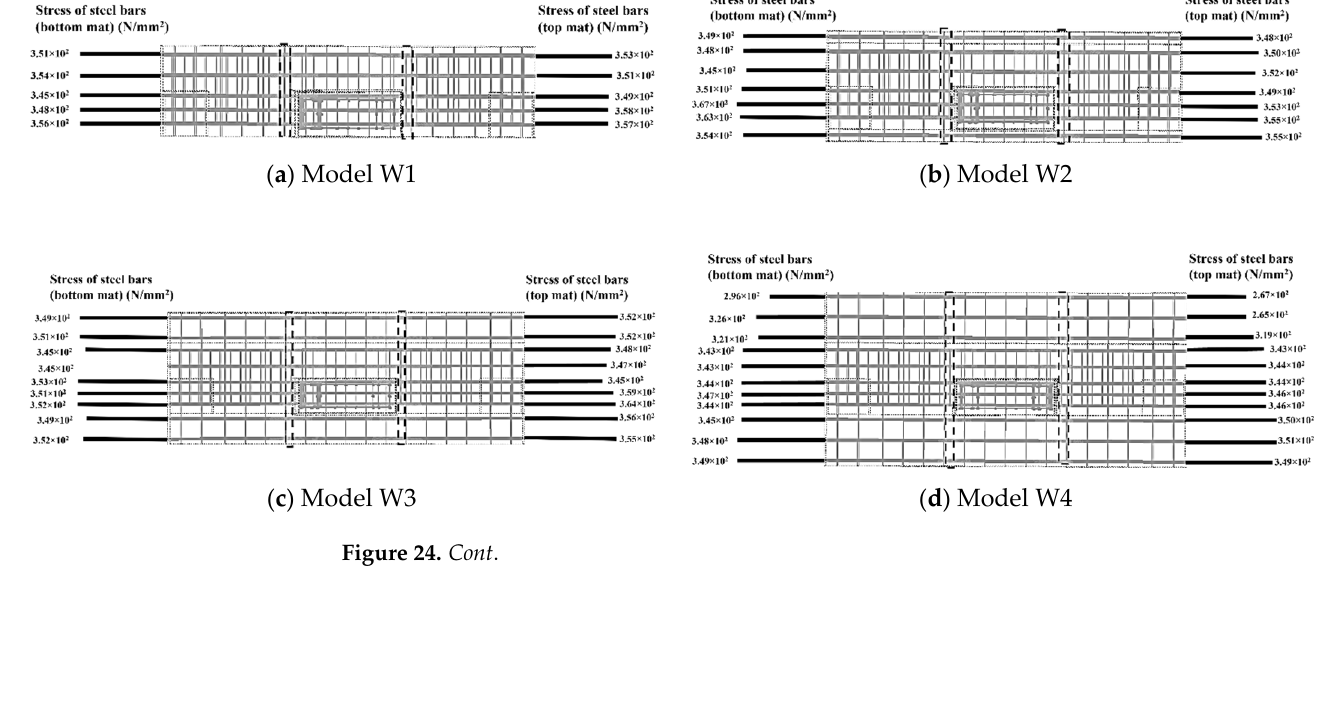
Figure 22. Simulation flexural strength versus calculated flexural strength for slab span length models.